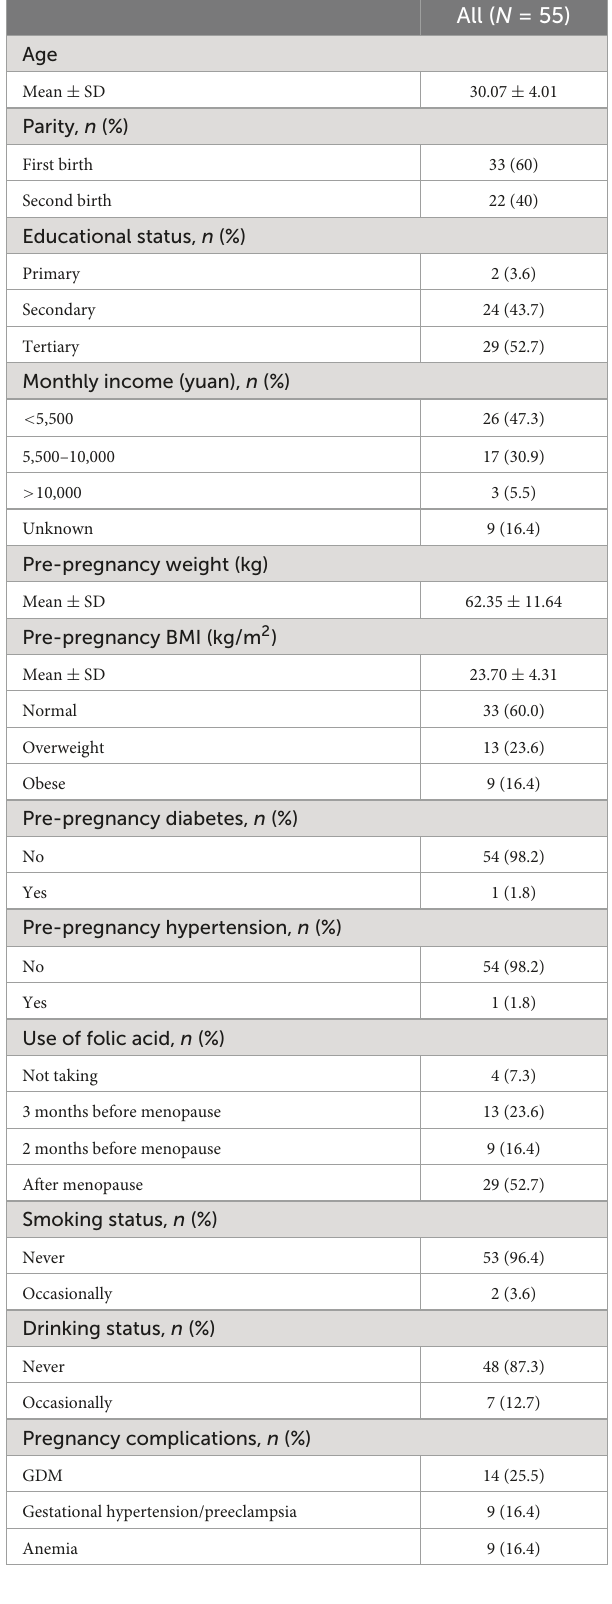
TABLE 1 Basic characteristic of study